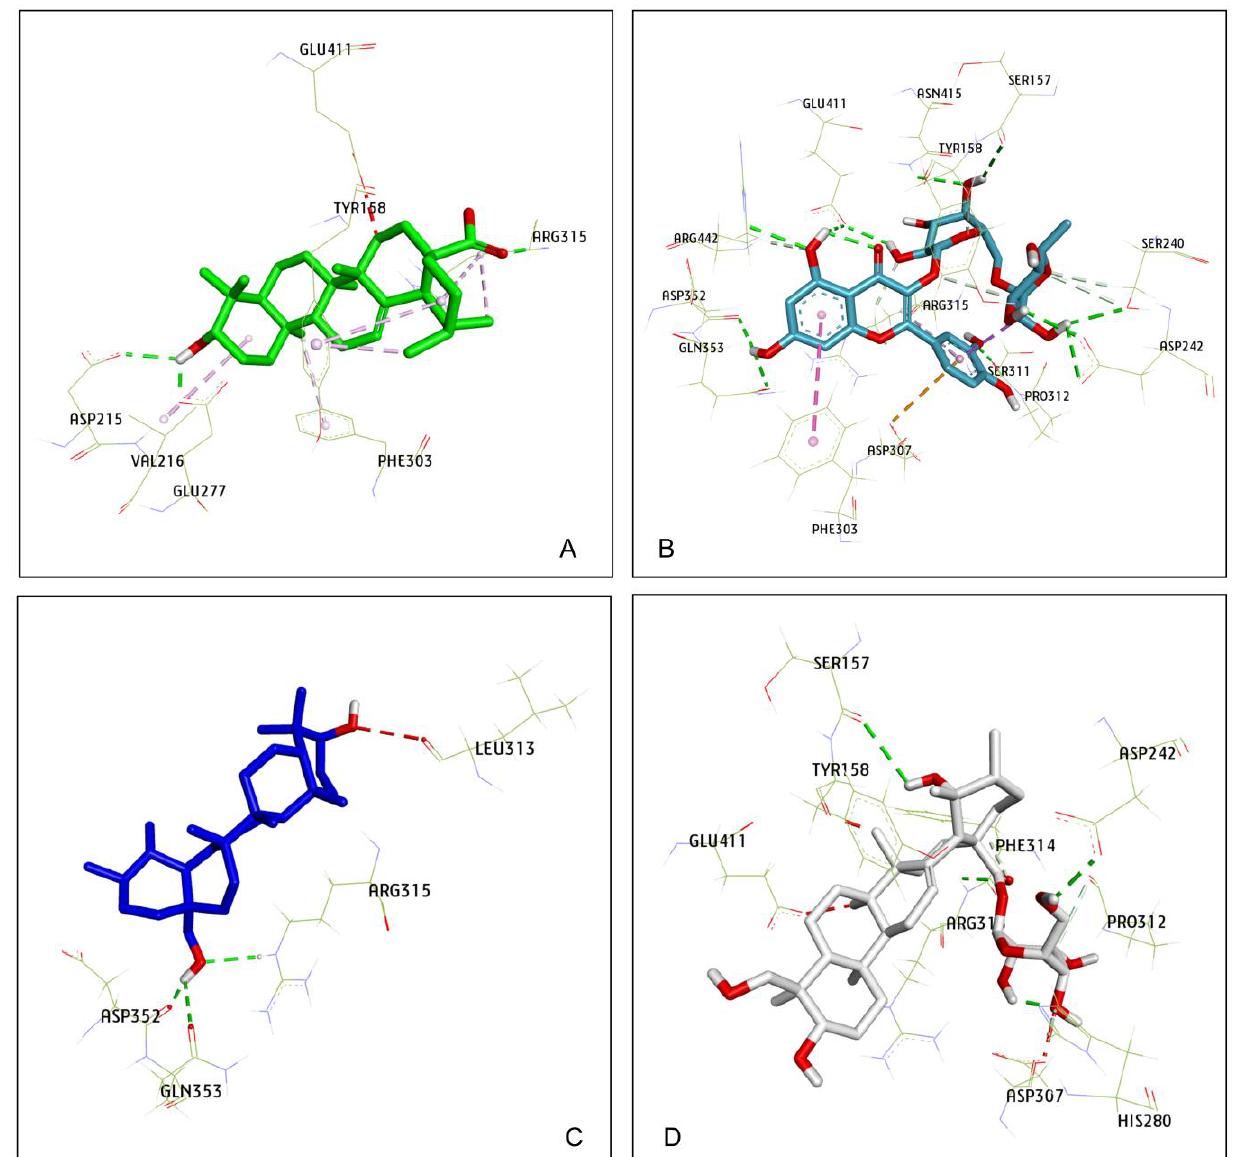
Figure 5. Compounds docked to the binding pocket of α -glucosidase. ( A ) Compound 5 — most ac- tive; ( B ) Compound 10 ; ( C ) Compound 4 ; ( D ) Compound 3 — least active. ( B ) Compound 10 ; ( C ) Compound 4 ; ( D ) Compound 3 —least